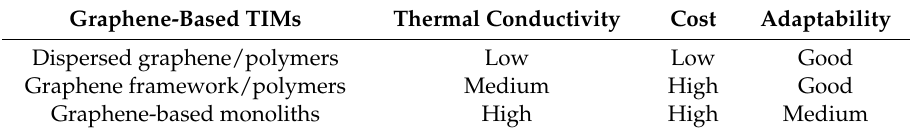
Table 4. Overview of three key parameters (thermal conductivity, cost and adaptability) of dispersed graphene/polymers, graphene framework/polymers and inorganic graphene-based monoliths for analyzing their advantages and disadvantages form application point of